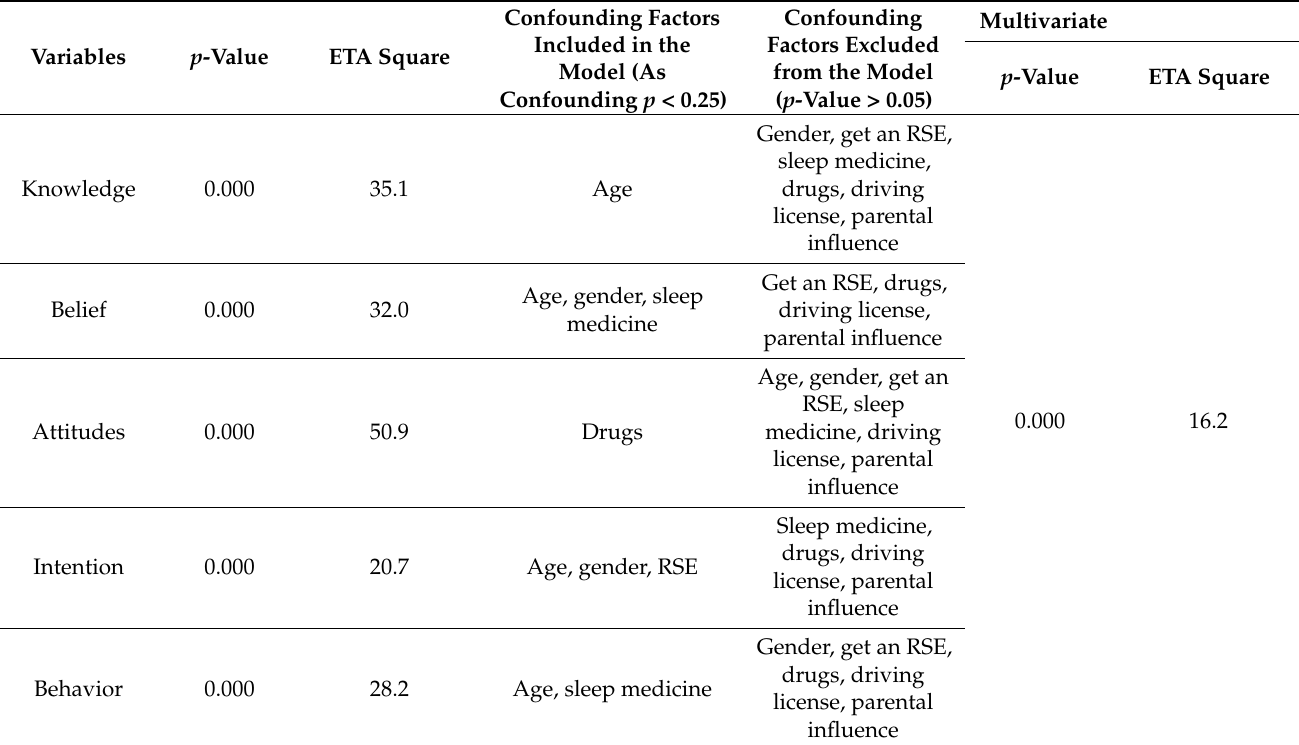
Table 3. Results of the general linear analysis of the repeated measure,